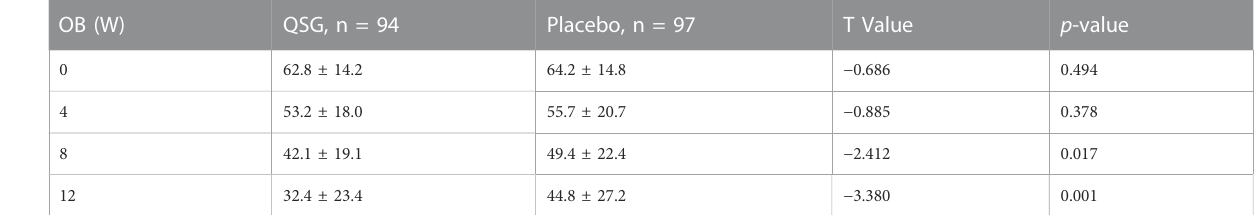
TABLE 9 TCM syndrome integral scale.